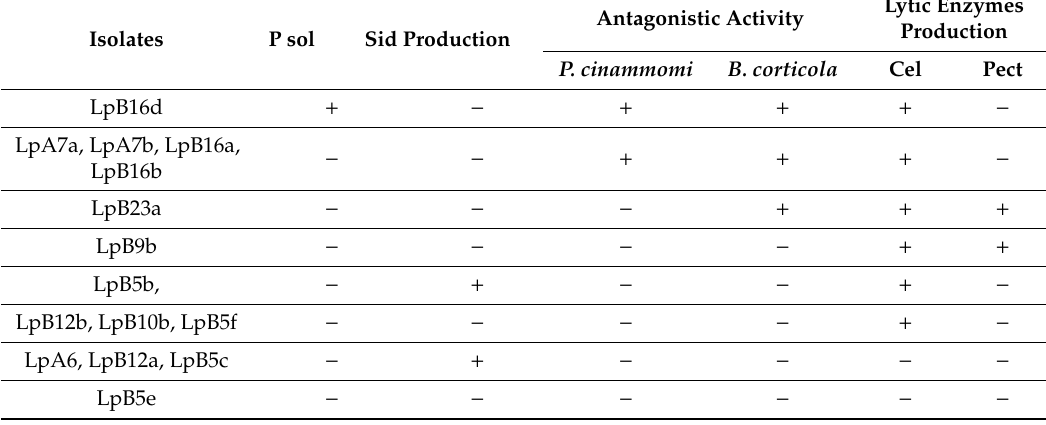
Table 4. Plant growth promotion (PGP) traits: Phosphate solubilization, siderophore production, antagonistic activity against phytophatogens, and lytic enzymes production. Only isolates that showed at least one activity assayed are presented, even though all isolates were tested. Lytic Enzymes Antagonistic Activity Production Isolates P sol Sid Production P. cinammomi B. corticola Cel